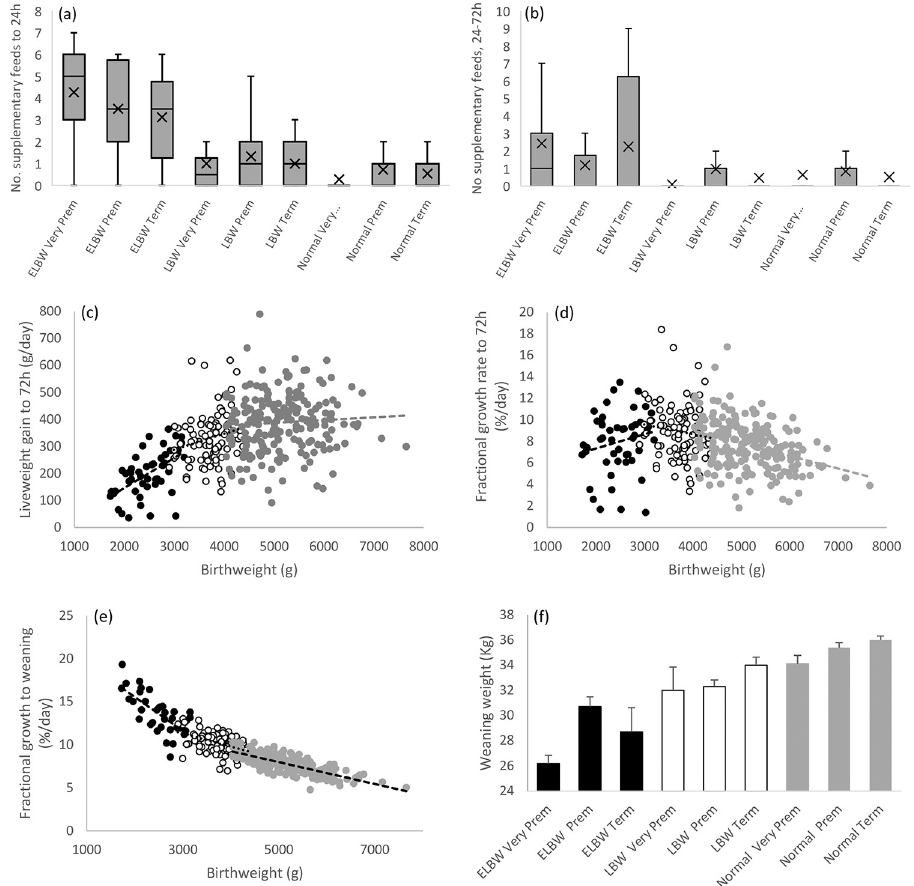
Fig 3. Supplementary feeding and indices of growth in relation to birthweight and delivery categories. Boxplots illustrating the number of supplementary feeds from 4 to 24h (a), and between 24 to 72h (b) after birth in relation to birthweight and delivery classifications, with mean (X) and exclusive median ( _ ). Relationship between birthweight and neonatal liveweight gain (c), and between birthweight and fractional growth rate to 72h (d) and 77 days postnatal (e), together with final weight at weaning for birthweight and delivery categories (f). For (a) and (b) birthweight was significant (P < 0.001/P = 0.001), but not delivery category (P = 0.362/P = 0.974), or the interaction (P = 0.166/ P = 0.173). For extremely low (black circles), low (open circles) and normal (grey circles) birthweight lambs in (c) r = 0.552 (P < 0.001), 0.206 and 0.066 (both ns); in (d) r = 0.190, -0.120 (both ns) and -0.357 (P < 0.001); in (e) r = -0.709, -0.423 and -0.766 (all P < 0.001). In (f) birthweight (P < 0.001) and delivery (P = 0.034) categories, and sex (males > females, P < 0.001) were significant but none of the interactions between